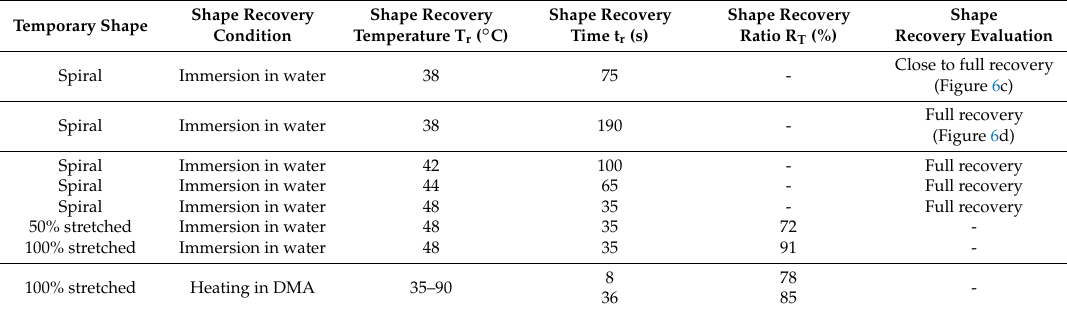
Table 3. Shape recovery parameters of the stabilized PLLAGLTMC nonwoven fabrics.